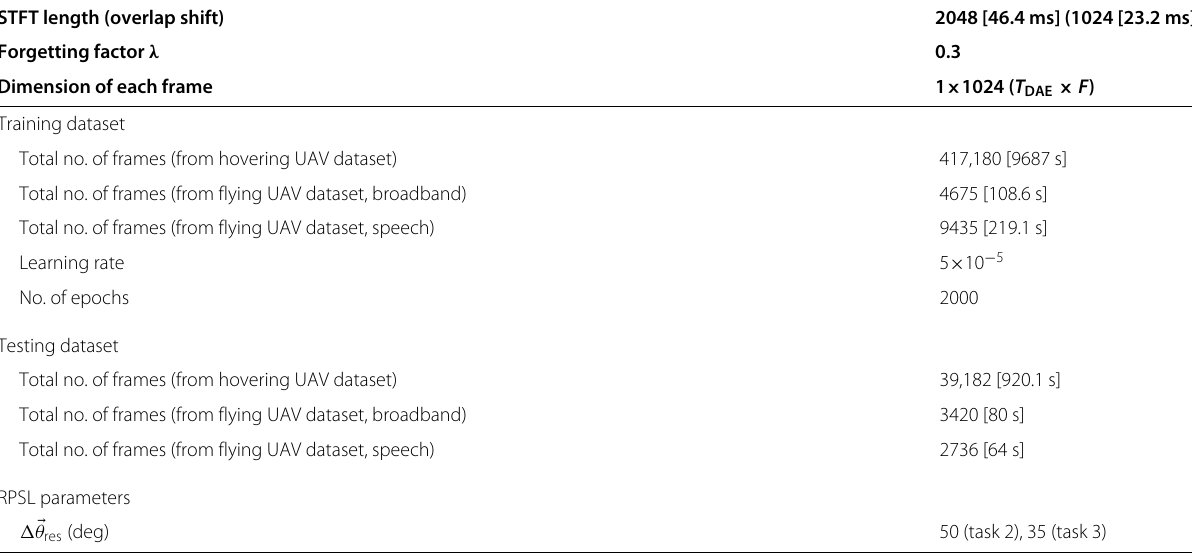
Table 2 Specifications and parameters for the rotor noise PSD estimation DAE and RPSL post-processing